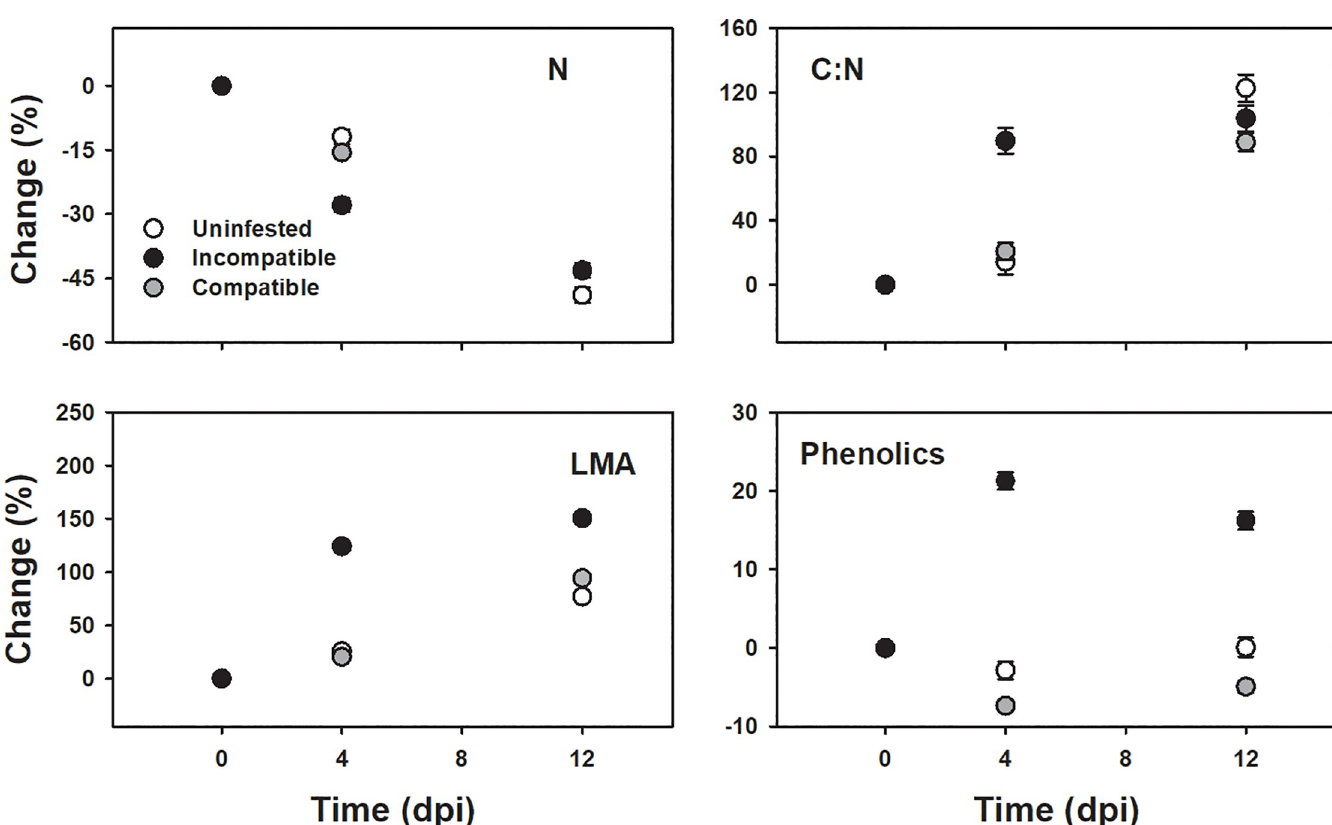
Fig 4. Mean ± SD of relative change, compared with the pre-infestation averages, of nitrogen (N), ratio of carbon to nitrogen (C:N), leaf mass per area (LMA) and phenolics to different infestation status (Uninfested, white circle; Incompatible, black circle; Compatible, gray circle) at zero, four and twelve days post infestation (dpi).